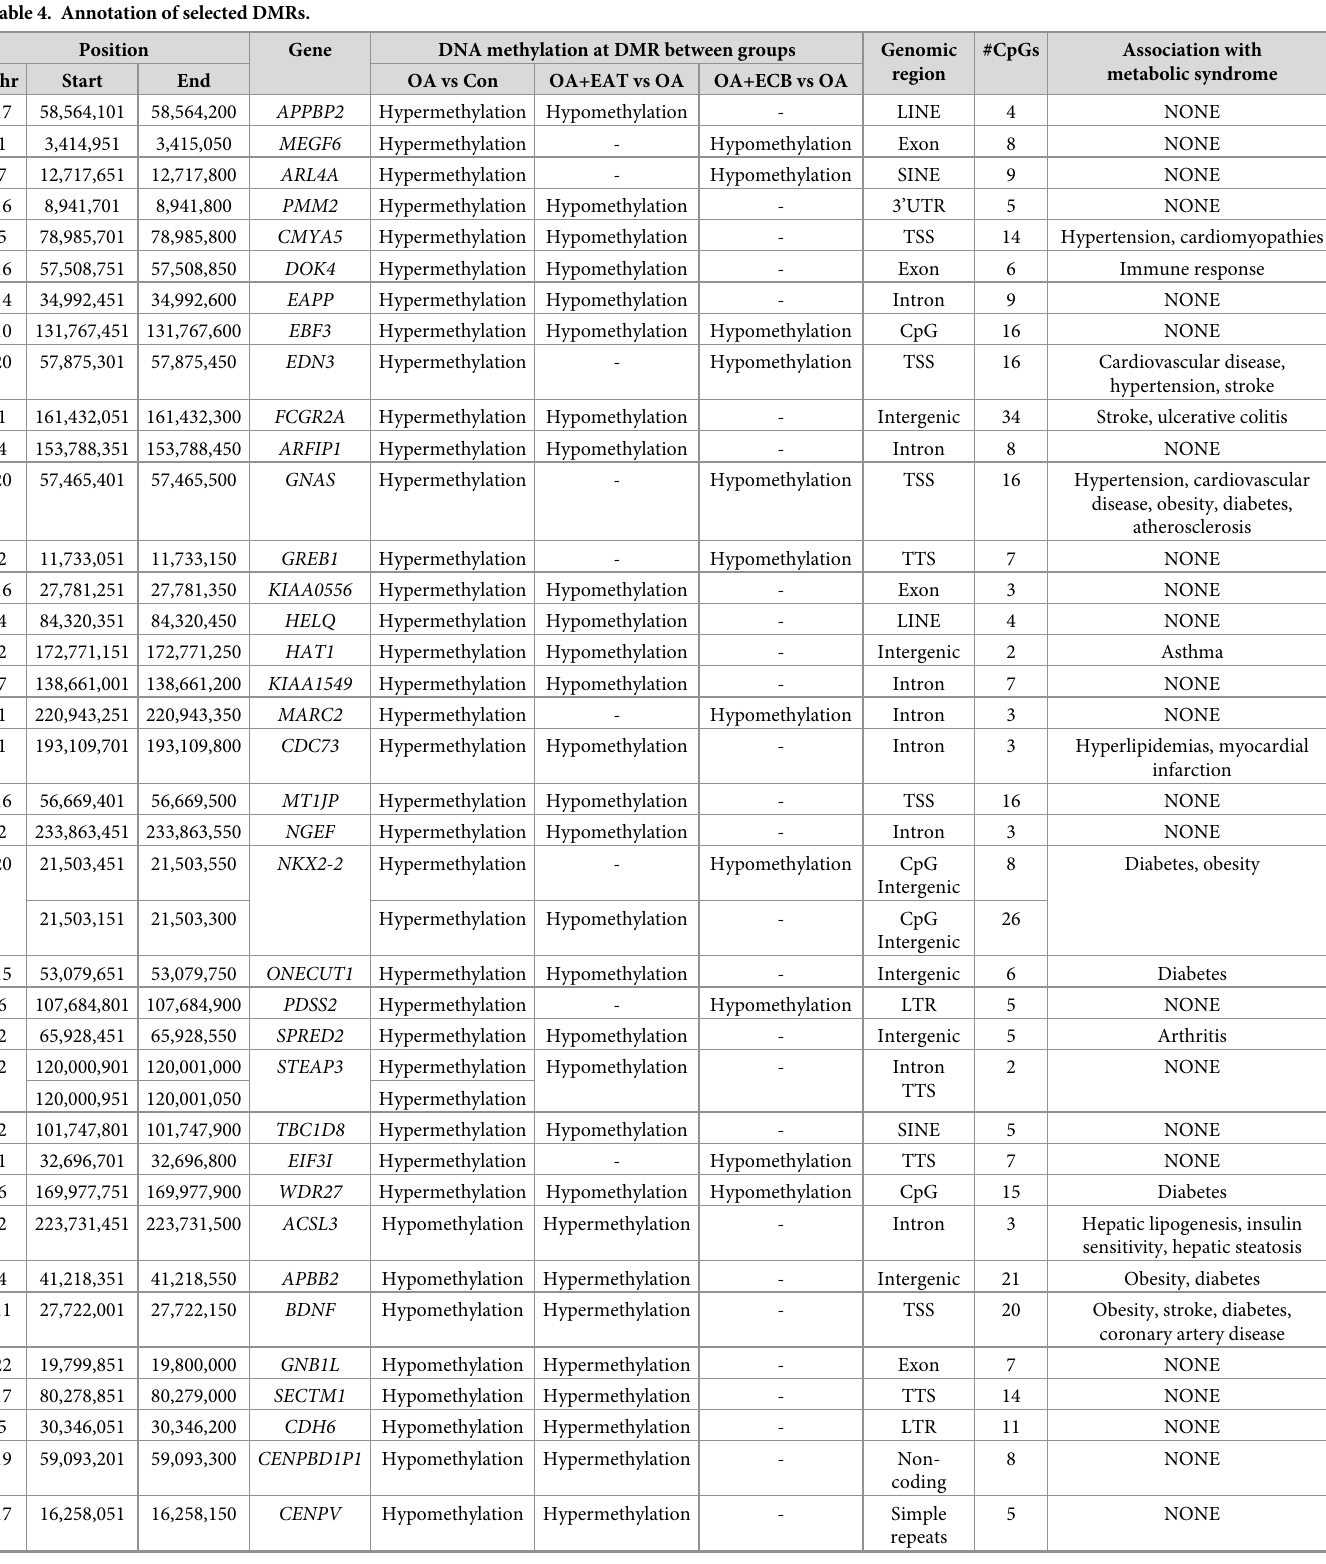
Table 4. Annotation of selected